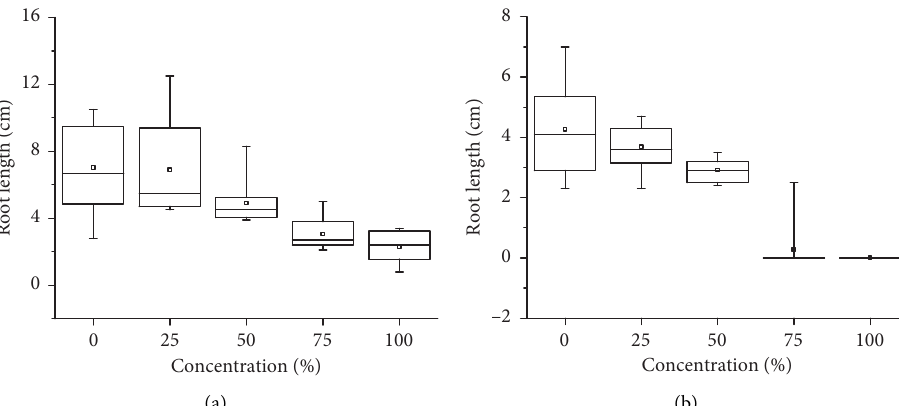
Figure 4: Root length of germinated P. vulgaris (a) and O. sativa (b) seedlings in screen house experiment after 7 and 14 days of treatment with S. suaveolens extracts, respectively.